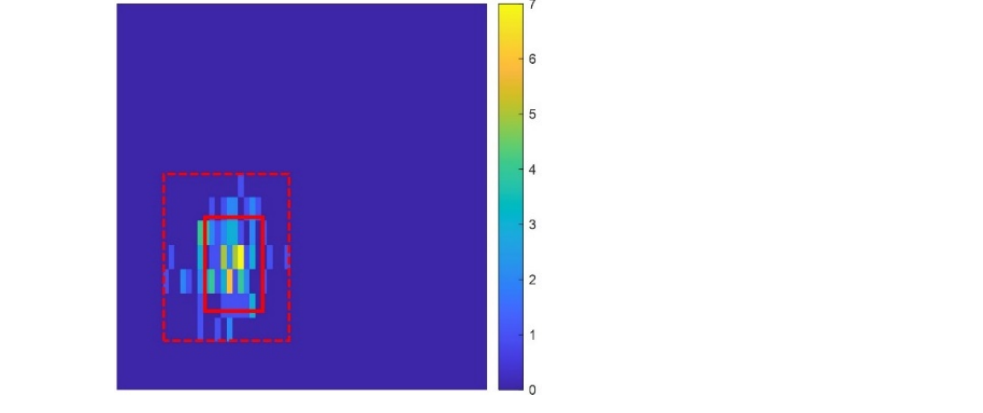
Figure 3. Two-dimensional distribution of upset cells (upset counts are consistent with the color bar in the right).